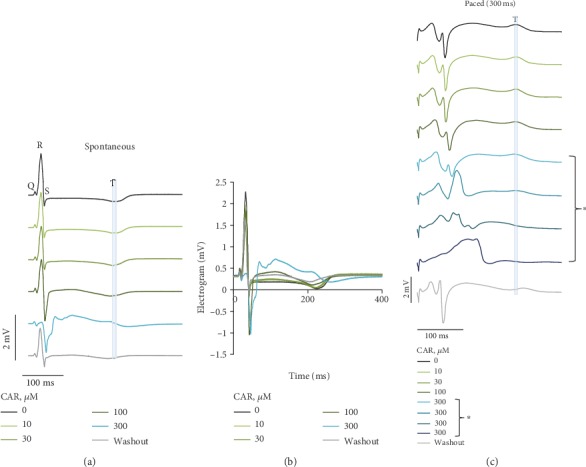
Representative traces of electrical activity registered on the Langendorff-perfused rabbit hearts. (a) Pseudo-ECGs under spontaneous rhythm in control conditions (black) and at 10, 30, 100, and 300 μM cumulatively increased concentrations of CAR (light green, green, dark green, and light blue, respectively) for 5 min under each condition, followed by 10 min perfusion without the drug (grey). (b) Superimposition of pseudo-ECG traces; same data as in (a). (c) Traces obtained from a unipolar electrogram of the LV under the same experimental conditions as in (a) but during epicardial stimulation. Note: marked slowing in conduction velocity (CV) and depression in T-wave amplitude at 300 μM CAR. Asterisk means electrogram traces presented in every 30 s (not after 5 min), when perfused with CAR at the 300 μM concentration (light blue, blue, dark blue, and navy, respectively).